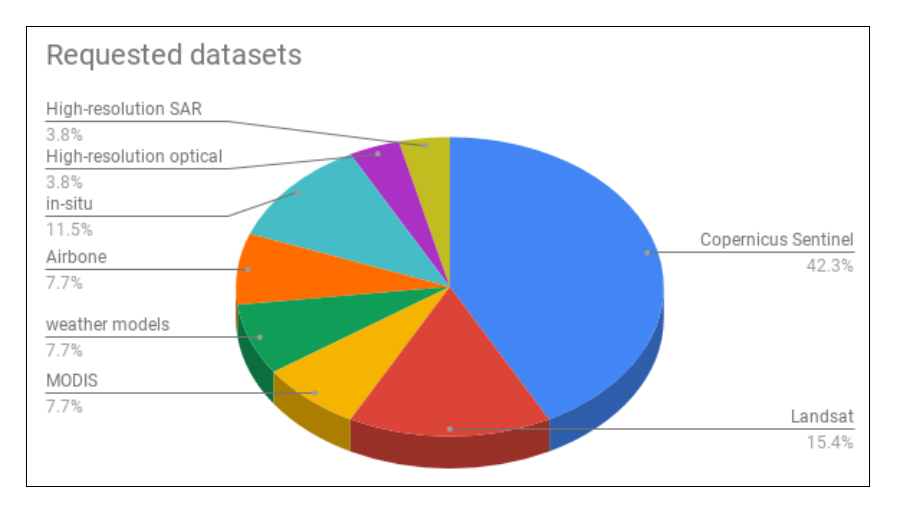
Figure 14. Requested datasets by the interviewed researchers.